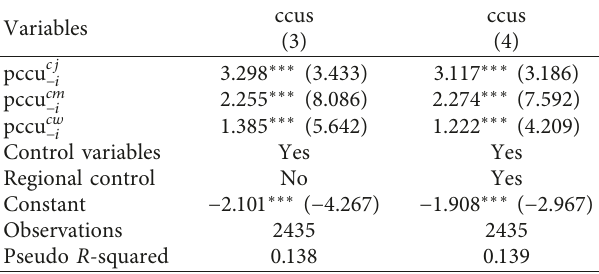
Table 7: Estimation results of the peer effects of farmer